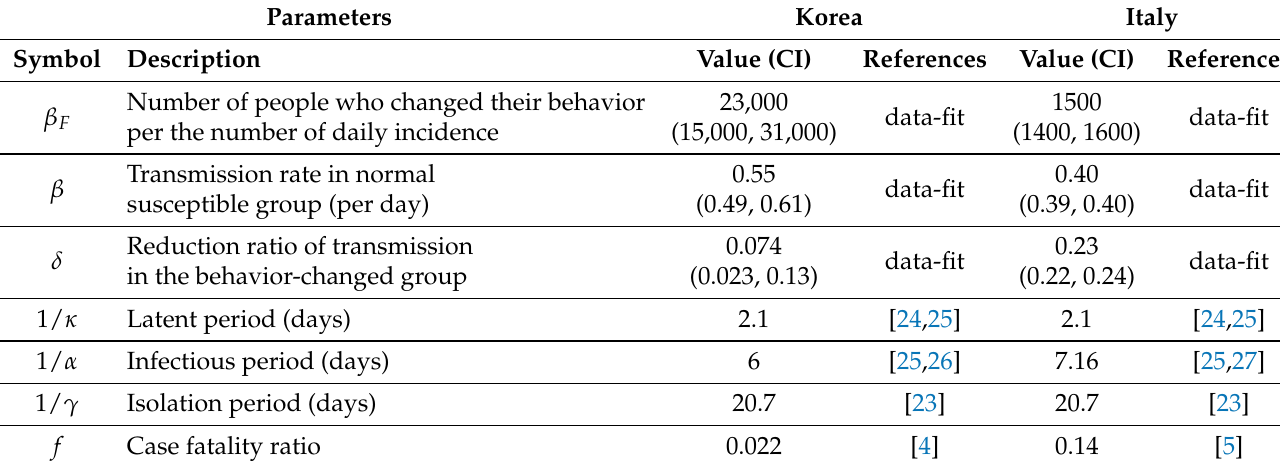
Table 1. Parameter values in Korea and